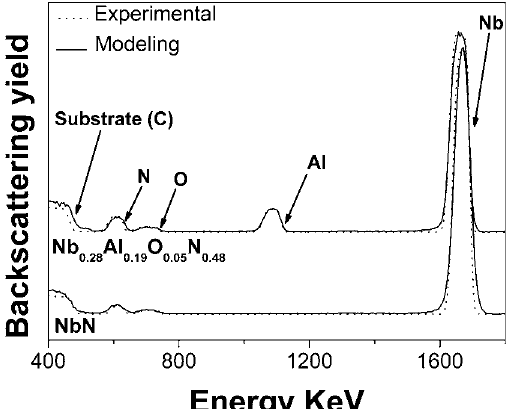
Al N samples as x y z